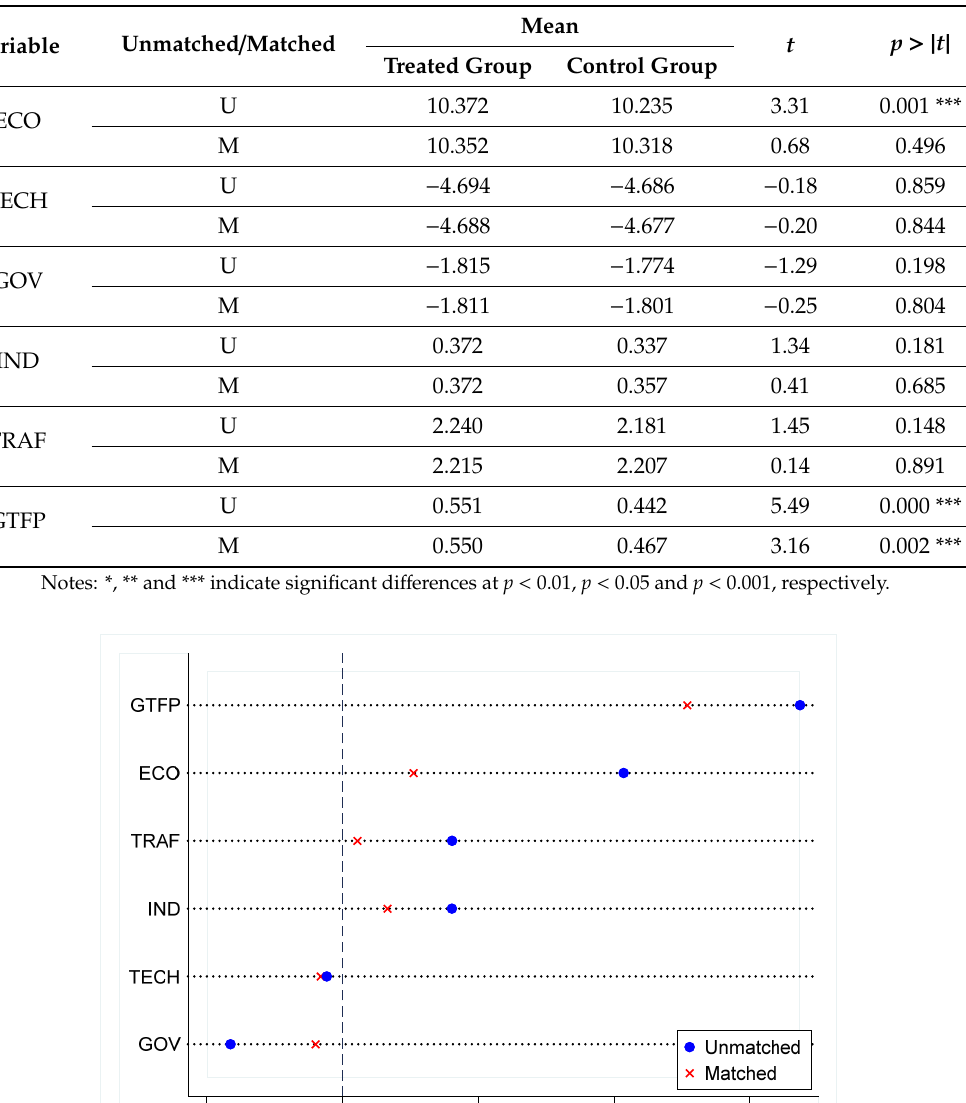
Table 4. Jointly support the hypothesis test.